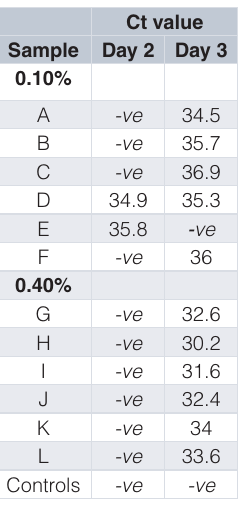
Table 4. Detection of Plasmodium falciparum DNA from the excreta/feces of individual mosquitoes collected using superhydrophobic cones.